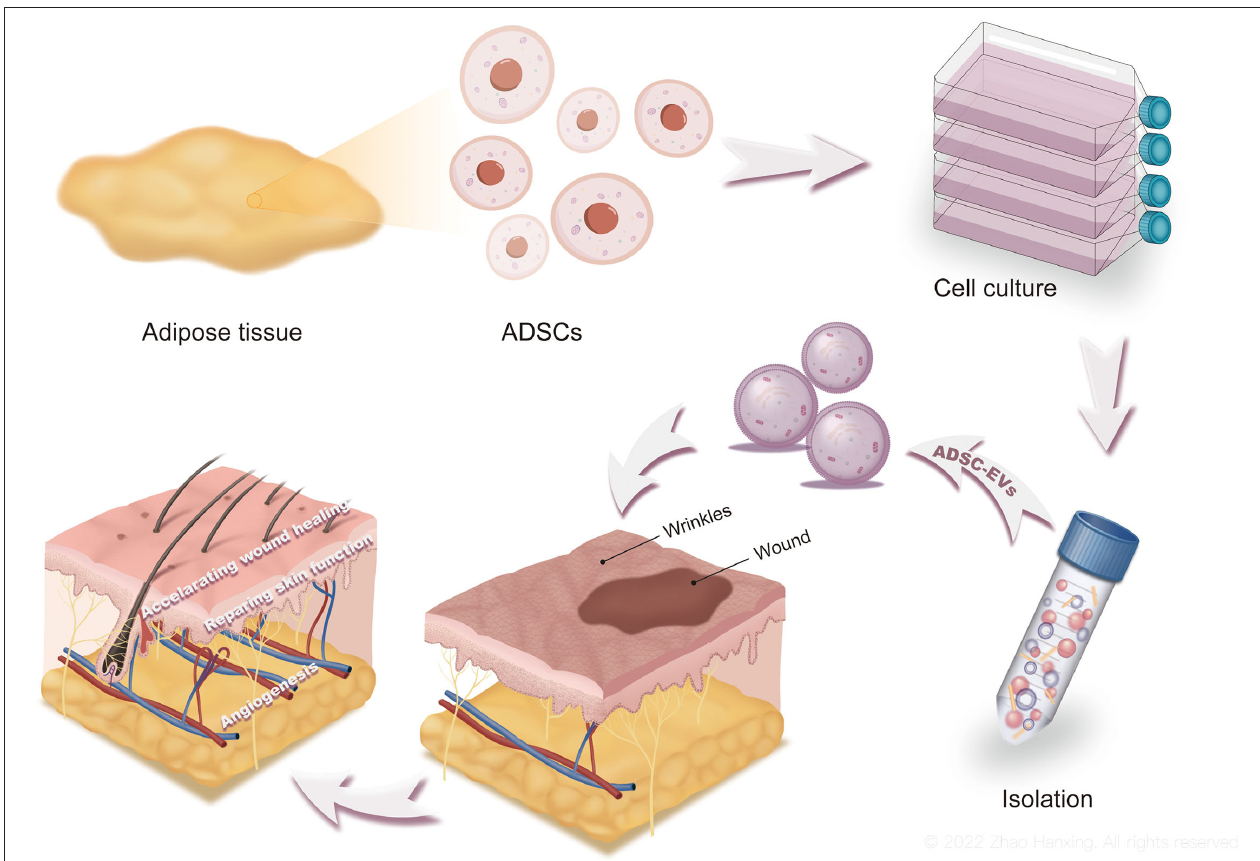
FIGURE 1 | The production, functions, and applications of ADSC-EVs. Culture medium of ADSCs was collected and processed to obtain ADSC-EVs. By accelerating wound healing and repairing skin function, ADSC-EVs promote skin regeneration. ADSC-EVs are promising for clinical applications as